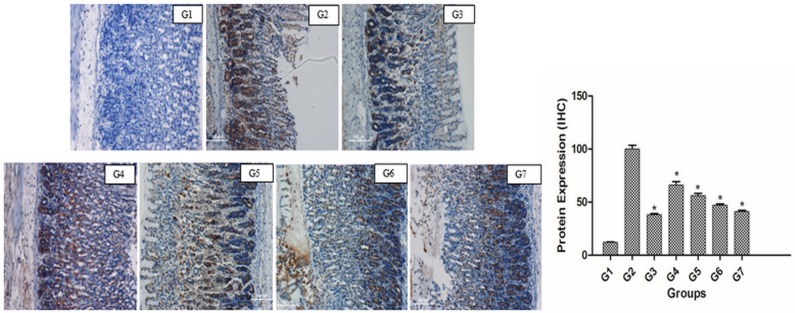
Effects of V. pubescens on immunohistochemical staining (Bax staining) of stomach wall in ethanol-induced gastric mucosal injury in rats.(G1) (Normal control group); (G2) (Ulcer control group); (G3) (Omeprazole); (G4) (62.5 mg/kg), (G5) (125 mg/kg), (G6) (250 mg/kg) and (G7) (500 mg/kg) of V. pubescens extract. Bax protein was over-expressed in ulcer control animals (brown) (magnification 20×). There were 6 rats in each group of experiment. The Image J program was used to evaluate protein expression. All values are expressed as the means ± the standard error of mean. The mean difference was significant at the p < 0.05 level compared to the cancer control group.